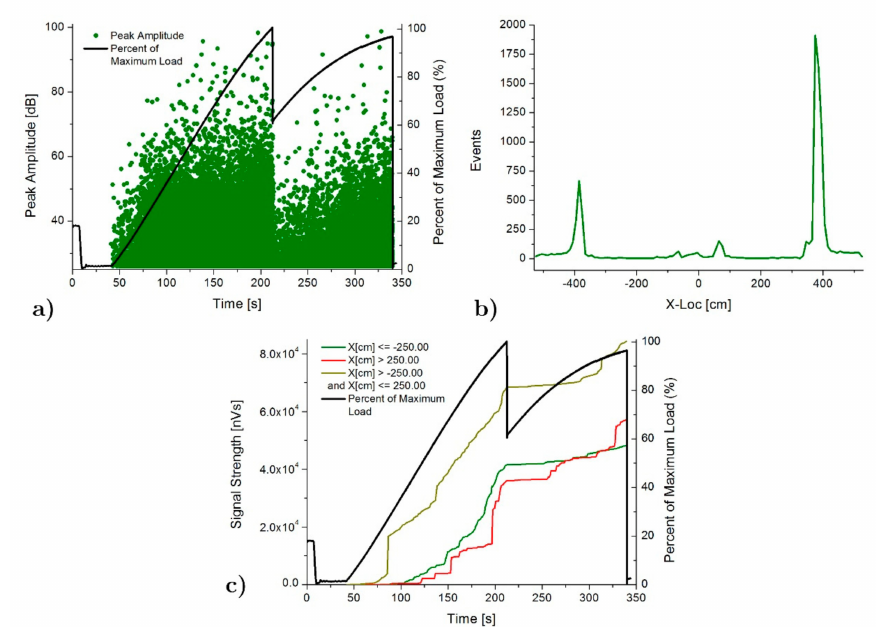
Figure 11. AE results for SFC specimen: ( a ) Peak amplitude vs load history over the time, ( b ) Linear location over the specimen and ( c ) Signal strength vs load history over the time.